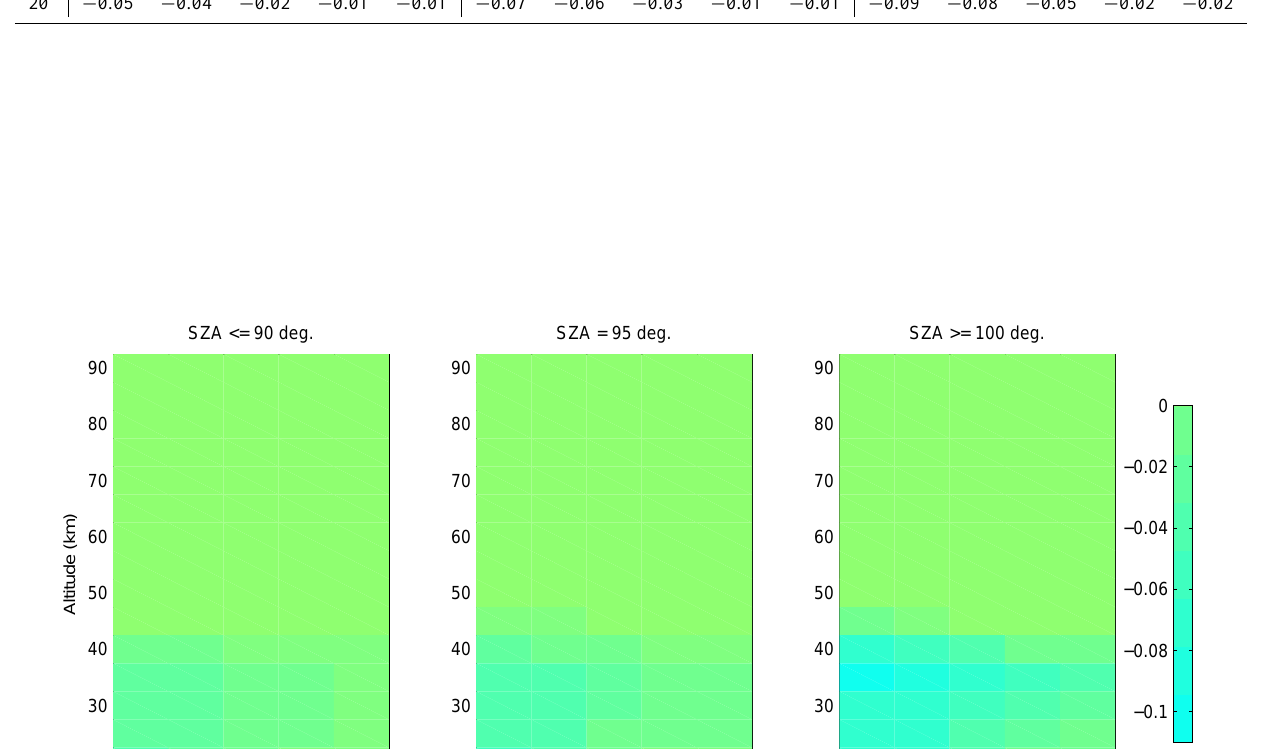
/Q for October 2 O 5